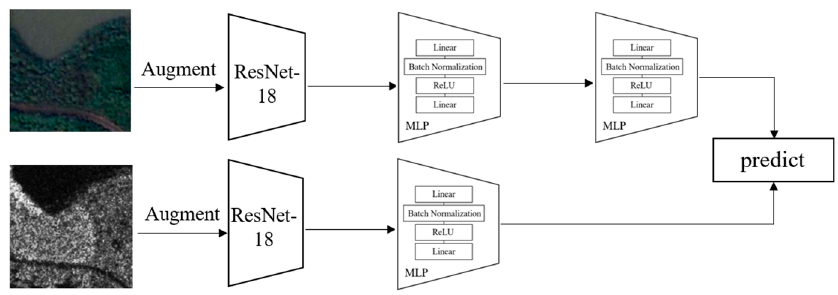
Figure 4. Asymmetric Siamese network.